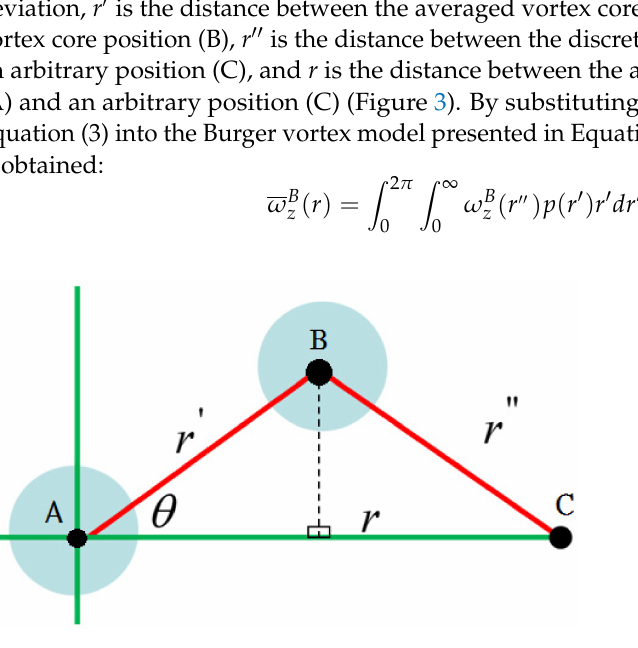
Figure 3. Vortex core position adjusted using the Gaussian